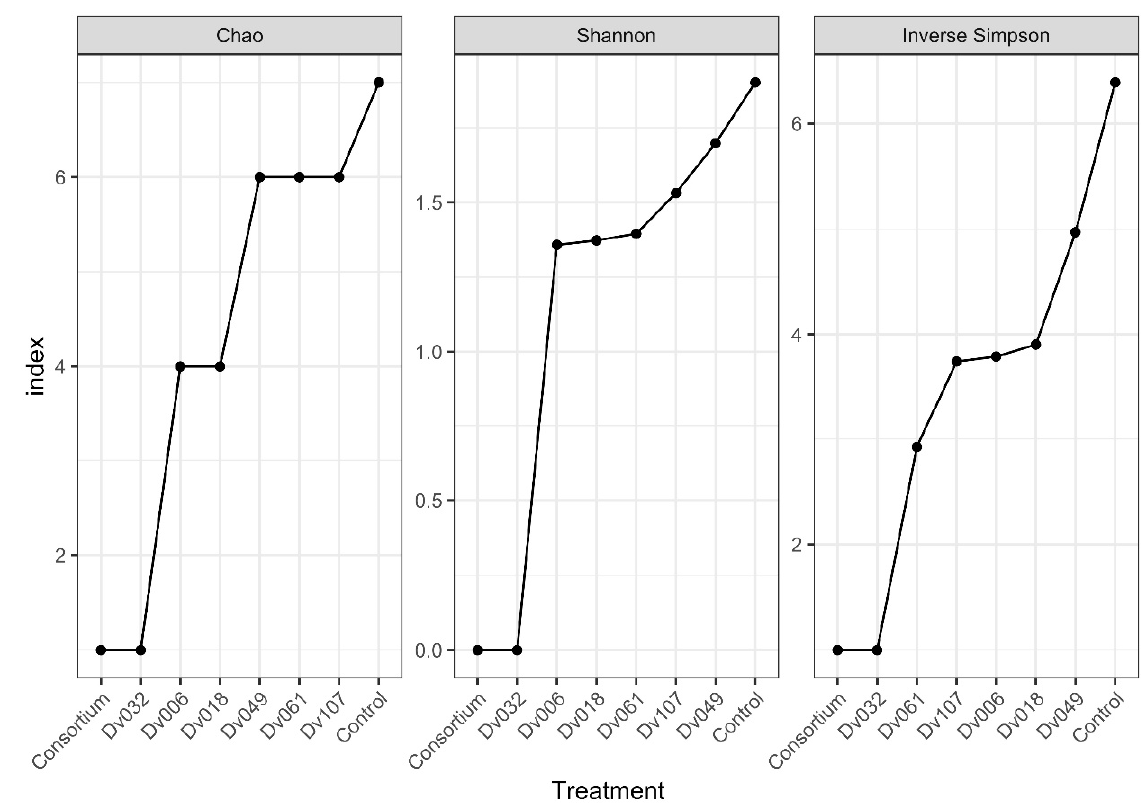
Figure 6. Biodiversity indexes of selected treatments based on the results of NGS analysis of the 16S rDNA region.